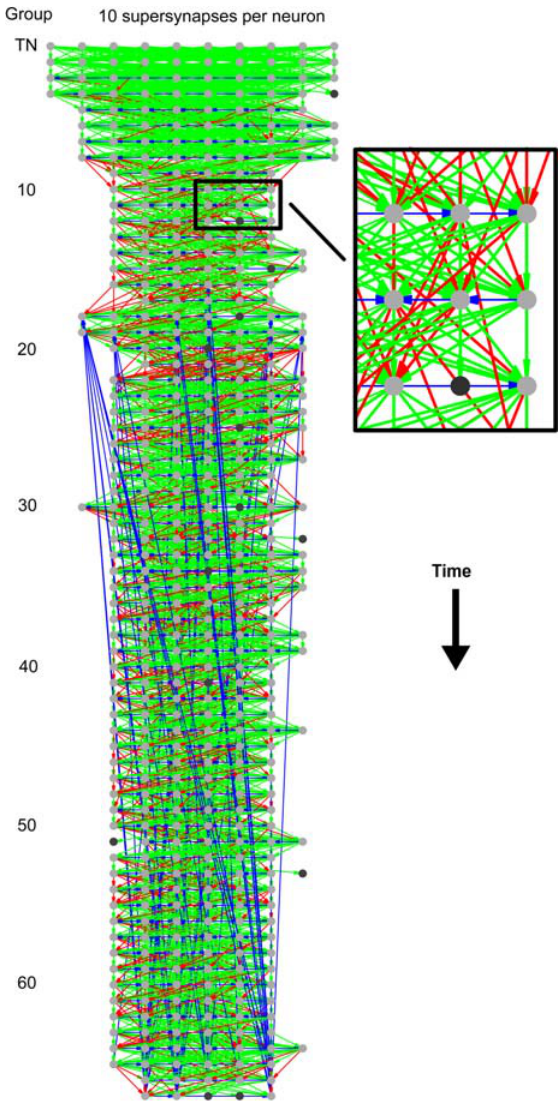
Figure 3. Topology of supersynapses of a developed network. Active synapses were originally laid down randomly with a connection probability 0.1. After 200000 trials, the neurons organize into a network that resembles a synfire chain (compare to Figure 1A). Only super- synaptic connections (arrows) and the neurons (circles) that receive them are shown. Light gray circles are saturated neurons; they have withdrawn their axons to all other neurons. Dark gray circles are unsaturated neurons; they have active subsuper synapses that are not shown. Green arrows are synapses that connect to neurons in the next group. Red arrows are synapses that connect to neurons in groups higher than the next. Blue arrows are synapses that connect to neurons in equal or lower groups. Neurons that are labeled in the same group are drawn horizontally in rows; these neurons fire near simultaneously. Successive groups are positioned vertically such that the relative spike time in the network flowing from top to bottom (see Text S1 for details of the algorithm used to assign groups). Each neuron had space to support 10 supersynapses. There were 10 neurons in the training set. Synaptic plasticity parameters for the simulation were set as follows. The LTP constant was G LTP =0.3; the synaptic conductance threshold for activation/inactivation was H A =0.2; the synaptic conductance threshold for supersynapses was H S =0.4; the maximum synaptic conductance was G max =0.6 (the unit of all conductances is the leak conductance of a neuron). The rate of synaptic decay—the amount by which each synapse is scaled down after every trial—was b =0.999996. See Materials and Methods for more details.